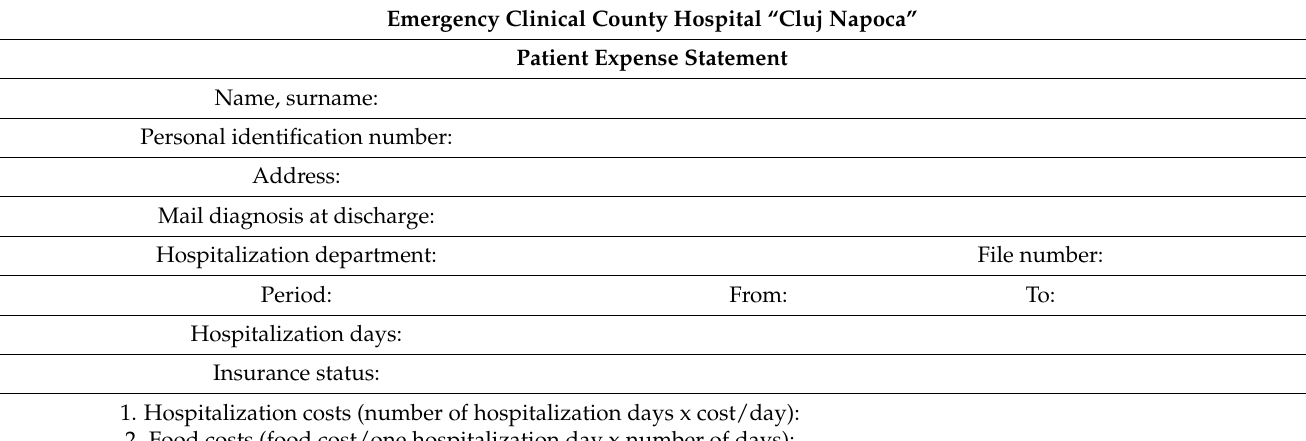
Table 1. Model of the patient expense statement completed at